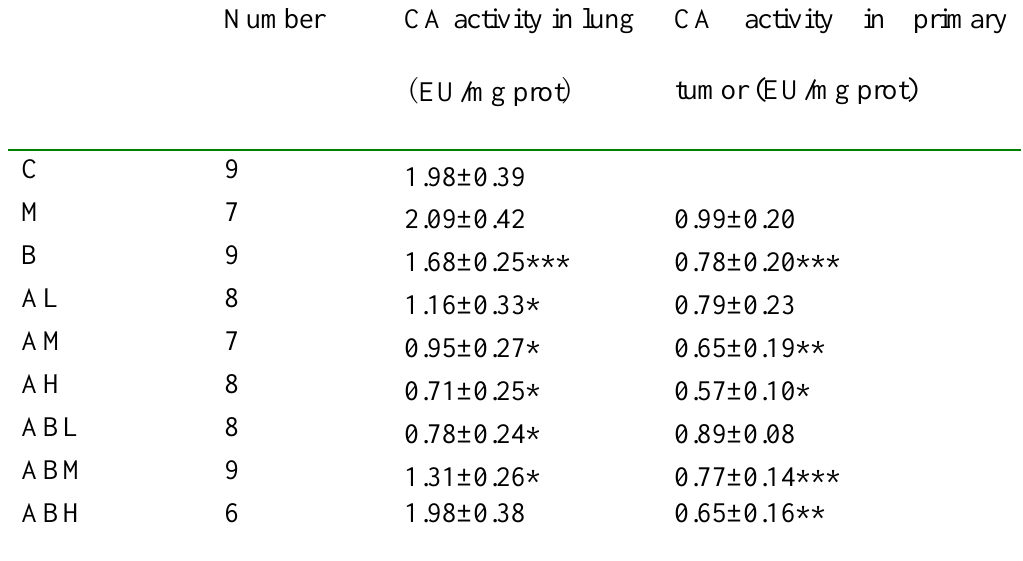
on total CA activity (mean±SD). C: 3 , AL: acetazolamide 20 mg/kg, AM: acetazolamide 40 mg/kg, 3 30 mg/kg, 3